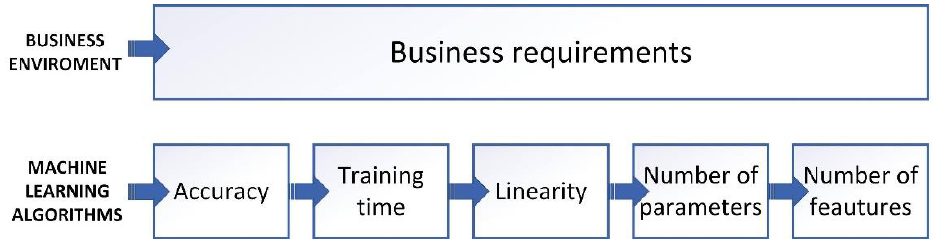
Figure 5. Criteria for selecting machine learning algorithms [28].